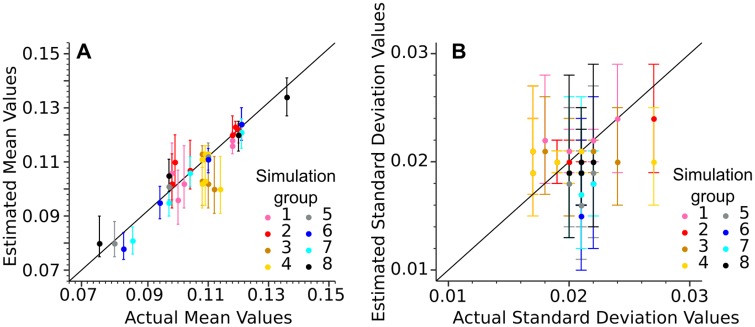
Scatter plots of actual mean thickness versus mean thickness estimated by the MCMC (A) and actual standard deviation versus standard deviation estimated by the MCMC (B) for each simulated component (simulated morphotype) in the various two- and four-component simulated samples.Each dot represents the median of each MCMC sampling with the error bars representing the 68% Credible Interval. Each color represents a different simulation group (see subsection on Markov Chain Monte Carlo analysis in the Methods section in text for details for each group).